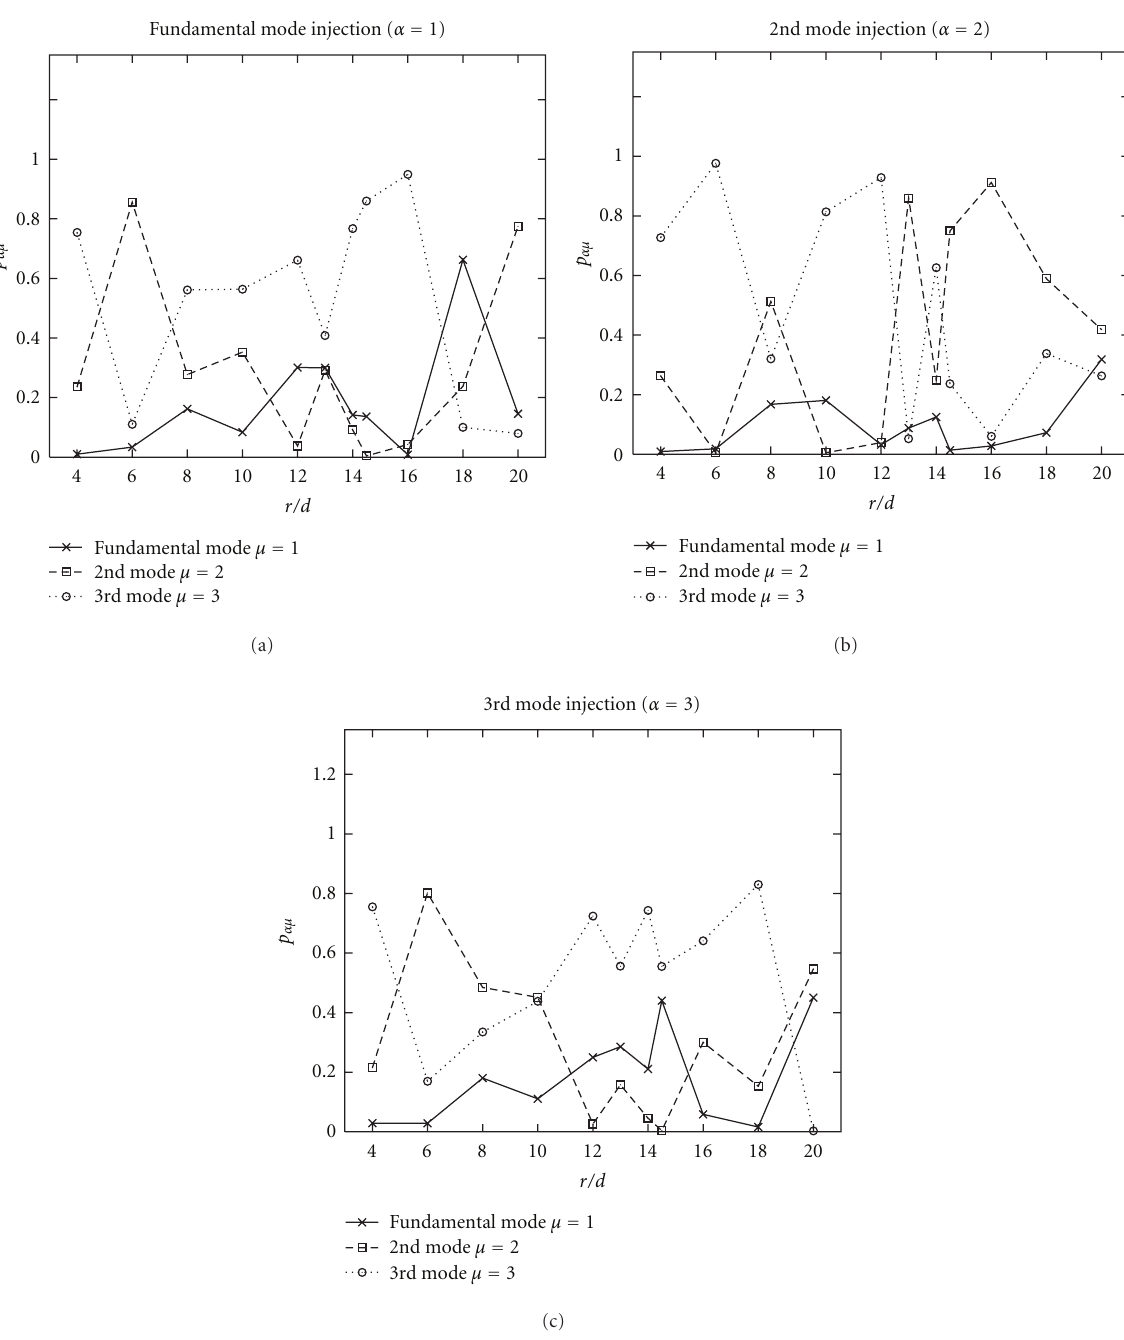
Figure 22: Size r/d dependence of the fraction p αμ in the transmission current carried by each propagating mode μ when each propagating mode α is injected. The wavenumber is set as Kd =